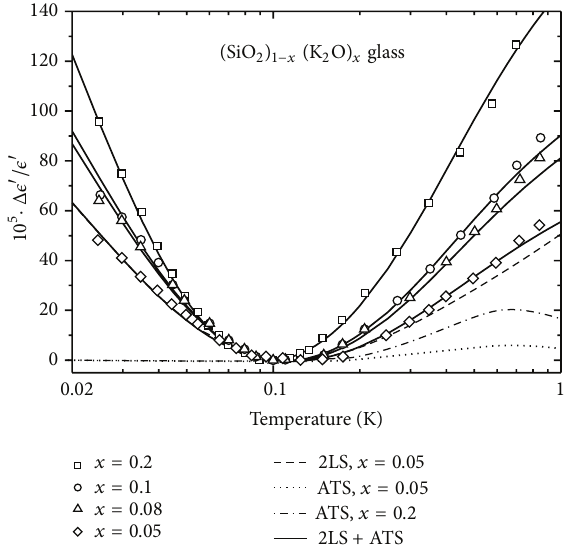
Figure 8: Dielectric signature of mixed ( SiO 2 ) 1−𝑥 ( K 2 O ) 𝑥 glasses as function of 𝑇 and 𝑥 [24]. Fitting parameters from Table 1 using (8) and (14) from our theory (driving frequency 𝜔 = 10